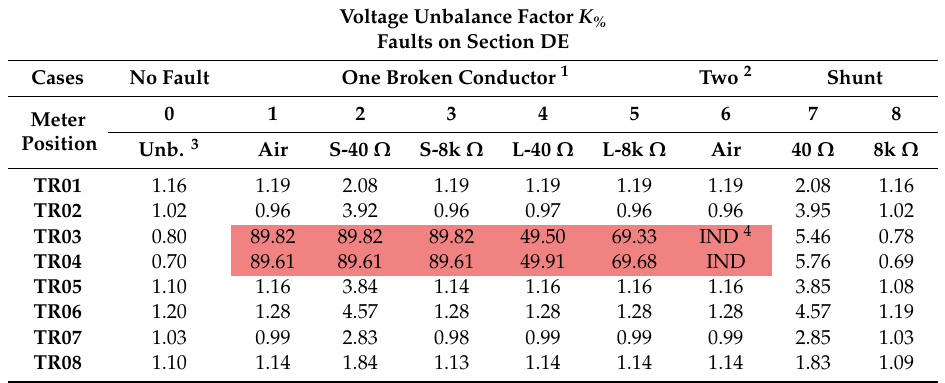
Table 6. Faults on section DE—voltage unbalance (results of K % for normal and fault condition).